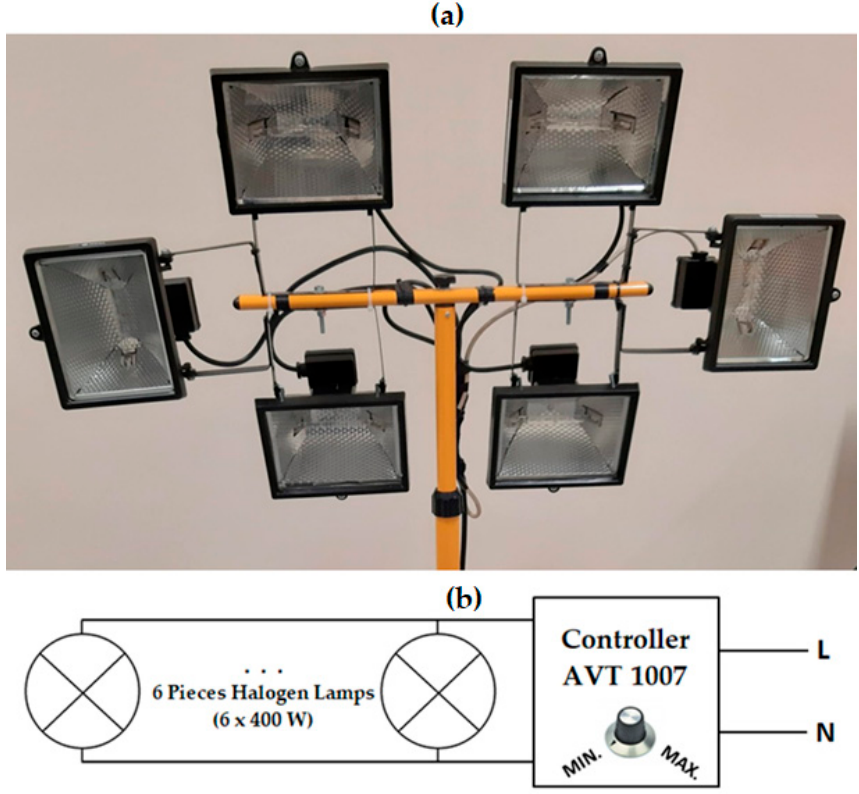
Figure 3. Construction of the Solar Light Pseudo Simulator: ( a ) photo of mounting halogen lamps; ( b ) electrical diagram of connecting the lamps to the controller that changes the intensity of radiation.